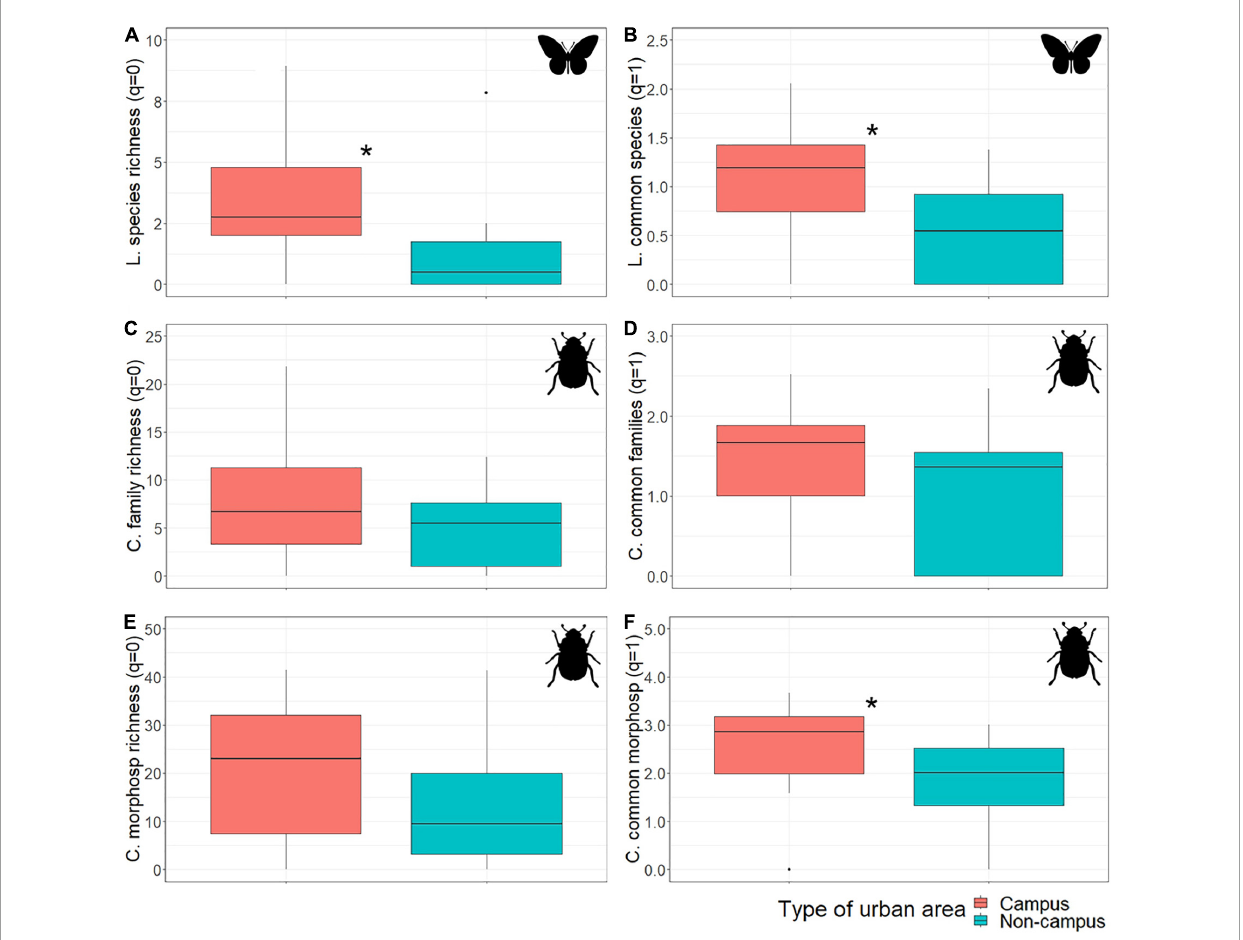
FIGURE1 Taxonomic diversity comparison between campus/non-campus: (A) Lepidoptera species richness ( q = 0), (B) Lepidoptera common species ( q = 1), (C) Coleoptera family richness ( q = 0), (D) Coleoptera common family ( q = 1), (E) Coleoptera morphospecies richness ( q = 0), and (F) Coleoptera common morphospecies ( q = 1). The boxplots show the median (bar inside the rectangles), upper and lower quartiles and extreme values. Significantly different pairs are marked with an asterisk. Colored bands represent confidence